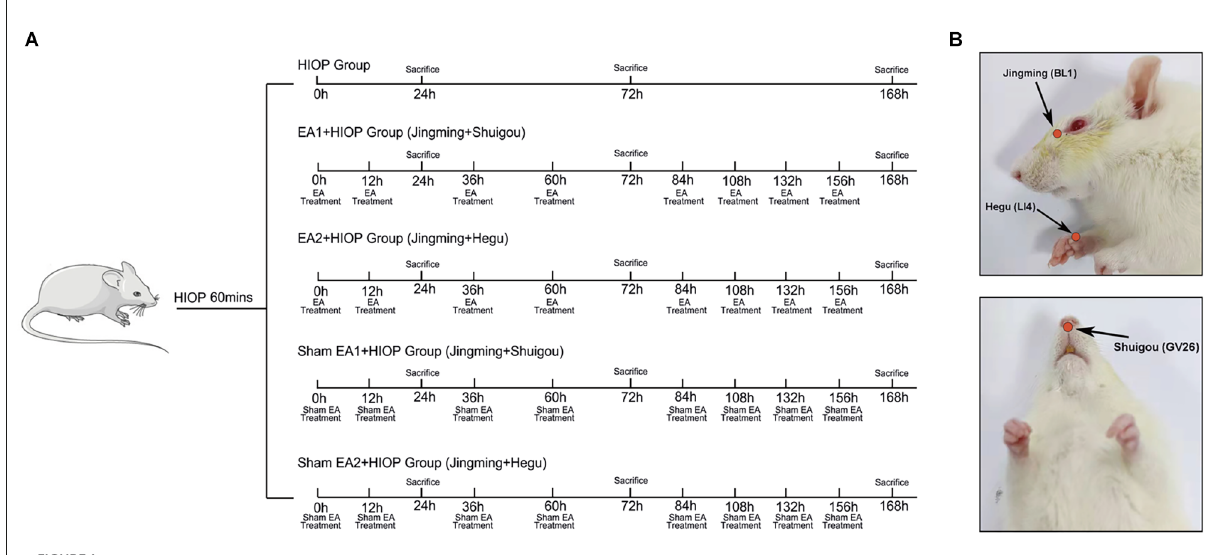
FIGURE1 (A) Detailed acupuncture time and frequency. (B) Acupoints diagram of a